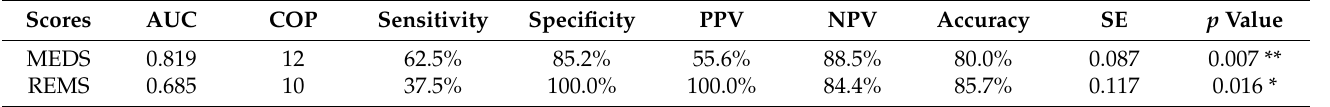
Figure 2. The AUC of ROC for REMS indicated 0.685 at 10 of the cut-off point to predict the mortality risks of patients with EC. AUC = area under the curve; ROC = receiver operating characteristic curve. Table 6. The AUC of ROC, cut-off point, sensitivity specificity, positive predictive value (PPV), negative predictive value (NPV), accuracy, and standard error (SE) of MEDS and NEWS to predict